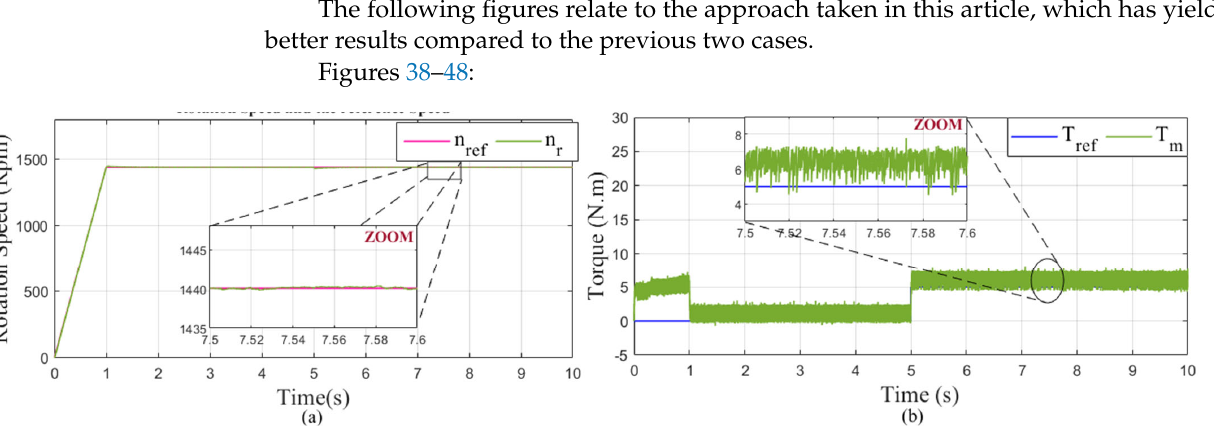
Figure 38. Performance in healthy state of IM with ANN ‐ DTC control: ( a ) rotation speed and ( b ) motor torque.